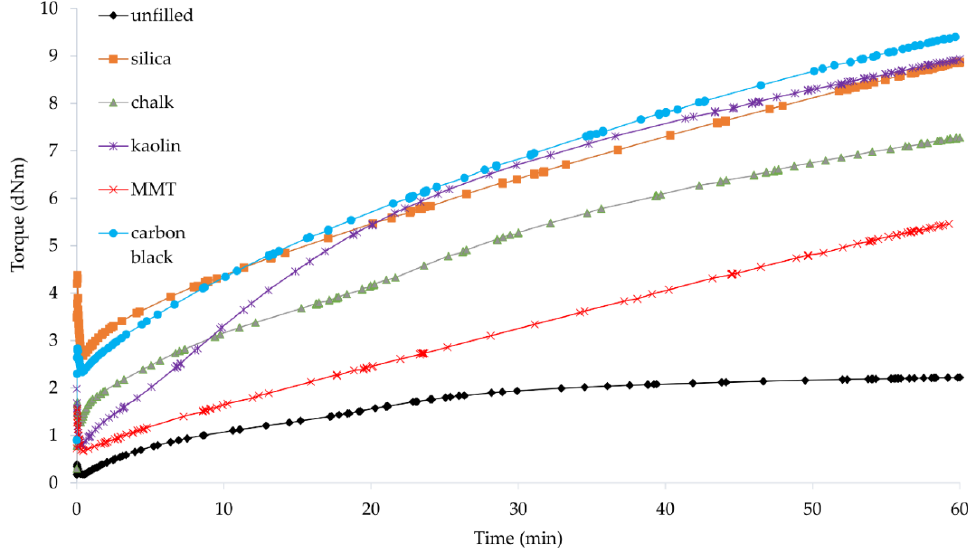
Figure 3. Vulcametric kinetics of filled CR cross-linked with copper(I) oxide (3 phr of Cu 2 O).